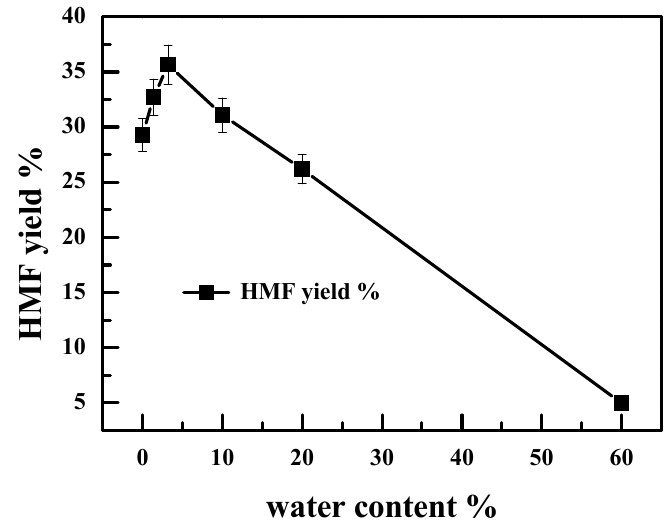
Figure 6. Effect of water content% on glucose dehydration.Experimental conditions: 0.1 g glucose, 0.15 g ZrOCl 2 , 0.05 g [HO 2 CMMIm]Cl, 3.0 g isopropanol, 3 h reaction time, and 150 °C reaction temperature.